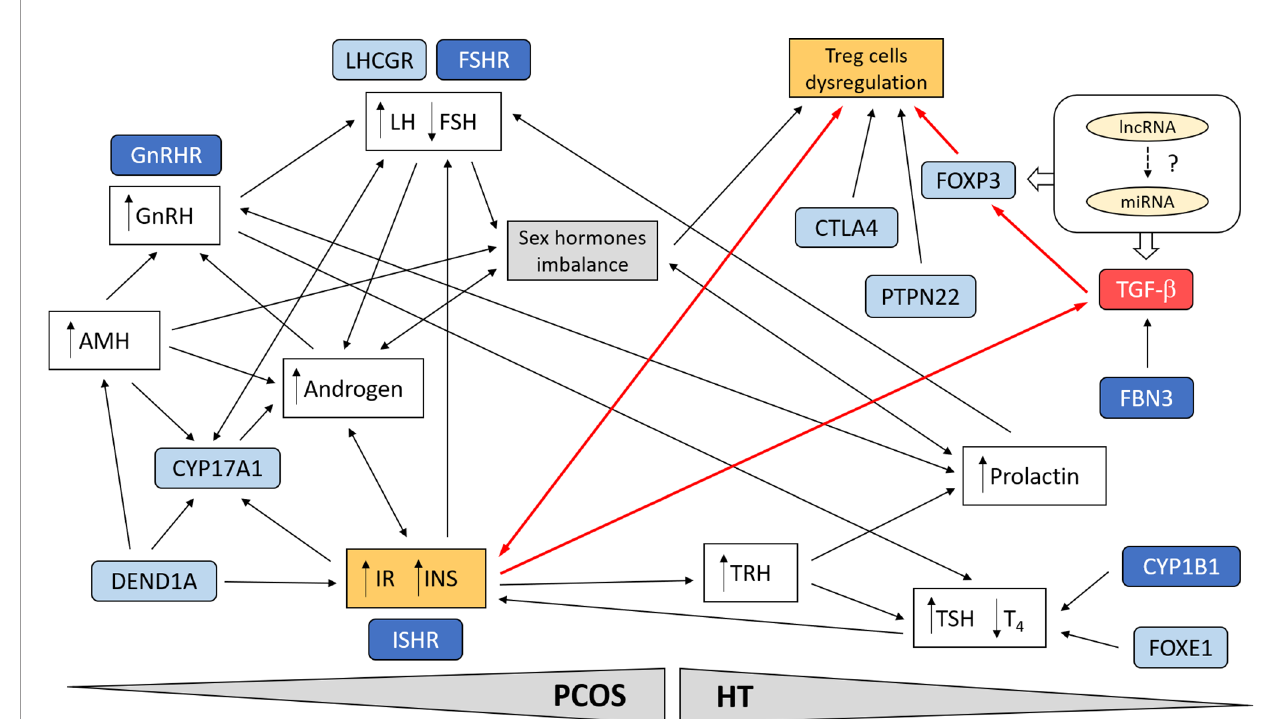
FIGURE 1 | Schematic presentation of possible cross-linkages between PCOS and HT. Involvement of the most important genetic factors and molecular pathways. Treg cell dysregulation emerges as a critical point in the genetic and functional network linking the two diseases. In PCOS, genetic variation emphasizes the contribution of both hormonal imbalance (gonadotropins, androgens, and female sex hormones) and metabolic factors (IR and INS secretion), often interacting through a feedback loop. Suppression of TGF- b signaling pathway in combination with IR may lead to dysregulation of Treg cells and promotion of autoimmunity in women with PCOS (red line connections). Possible interaction of ncRNA (miRNA, lncRNA) with TGF- b signaling. The most important genes are indicated in blue; darker blue designates susceptibility genes for both